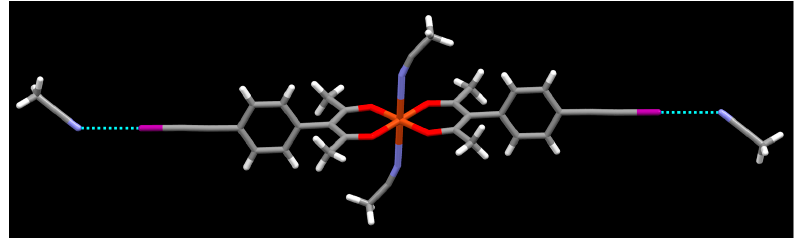
Figure 12. Part of the crystal structure of [Cu( L3 ) 2 ] · 4CH 3 CN showing the geometry around the metal ion and the ligand-solvent halogen bond (color codes: red—oxygen; blue—nitrogen; purple—iodine; orange—copper).